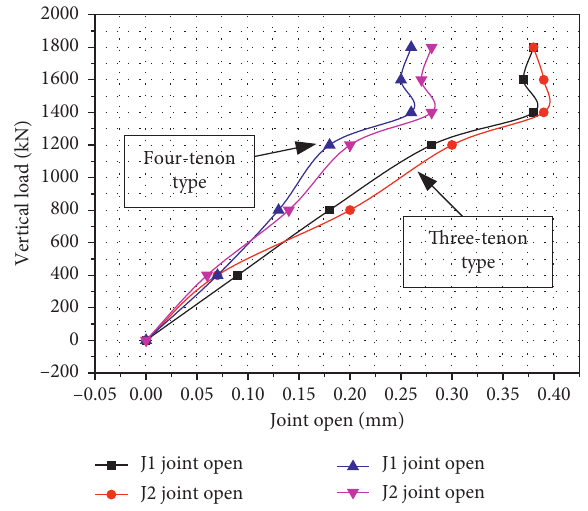
Figure 14: The open amount without longitudinal